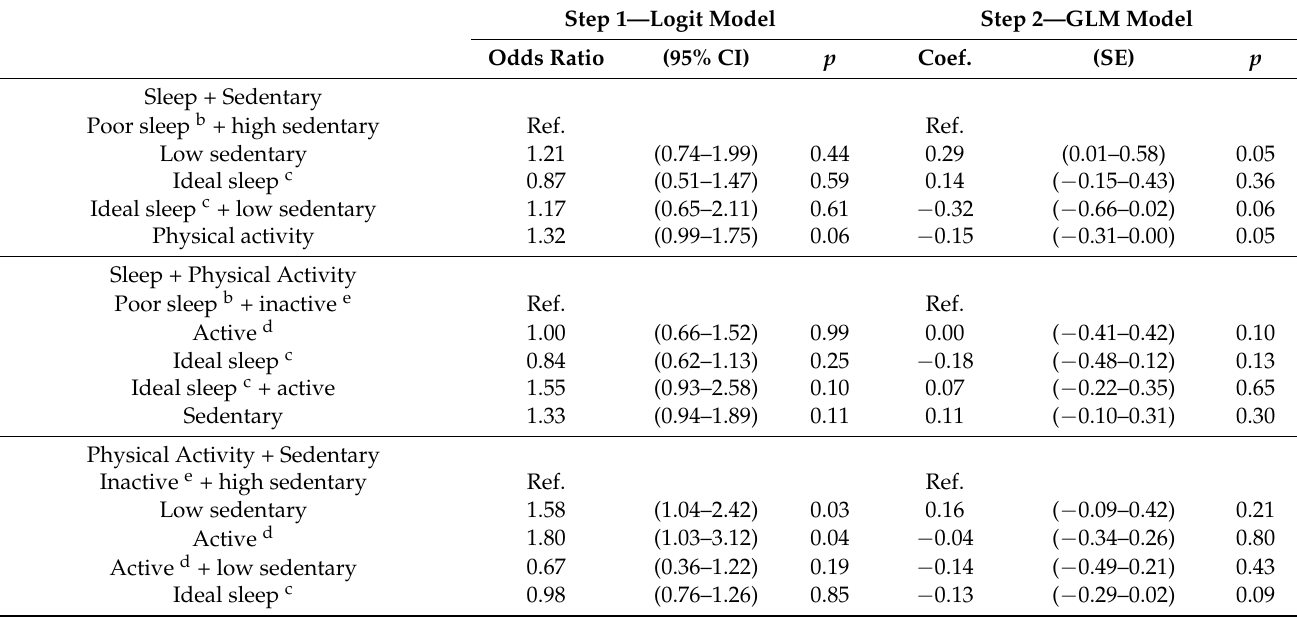
Table A1. Two-step regression analysis of joint associations of sleep, sedentary time, and physical activity with long-term weight loss success a